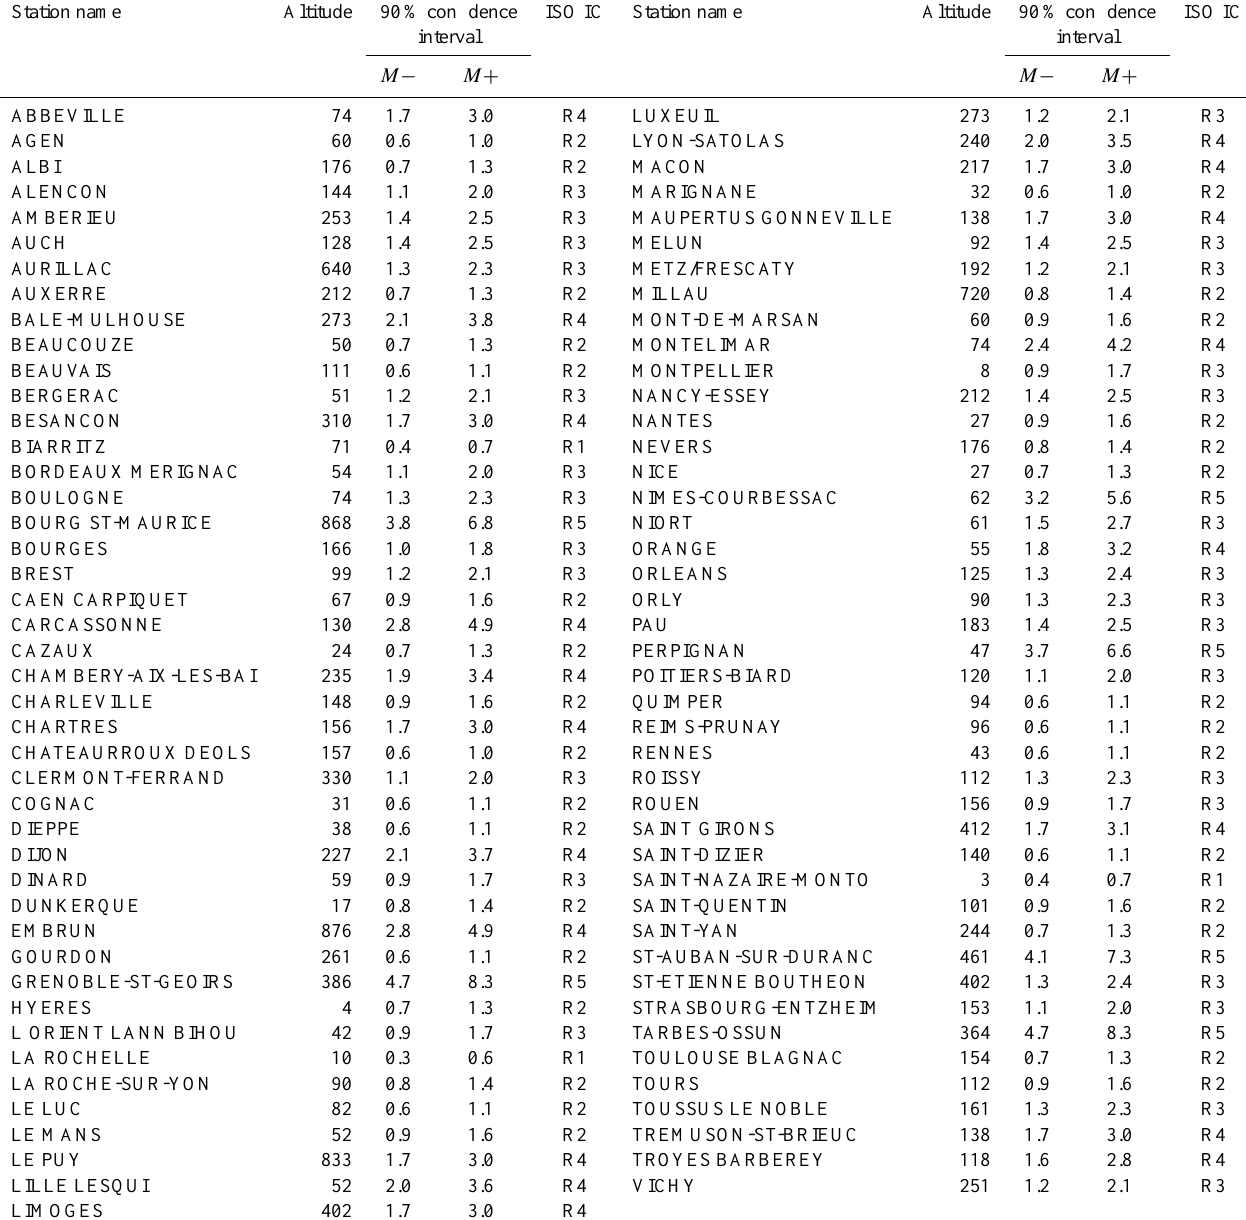
Table 4. 87 French weather stations with their names, altitudes, 90% confidence intervals and ISO